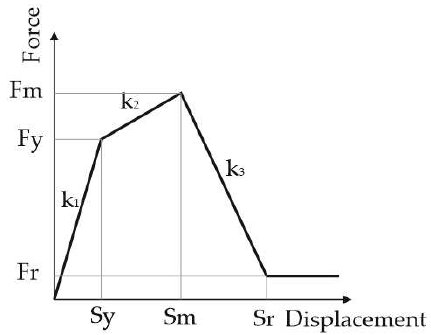
Figure 4. The numerical model in ( a ) 3D view; ( b ) longitudinal frame and ( c ) transversal frame. depicted in Figure 5 . Each single strut has been modelled employing one nonlinear link with a nonsymmetric constitutive law based on the Panagiotakos and Fardis’s research [37], depicted in Figure 5 .